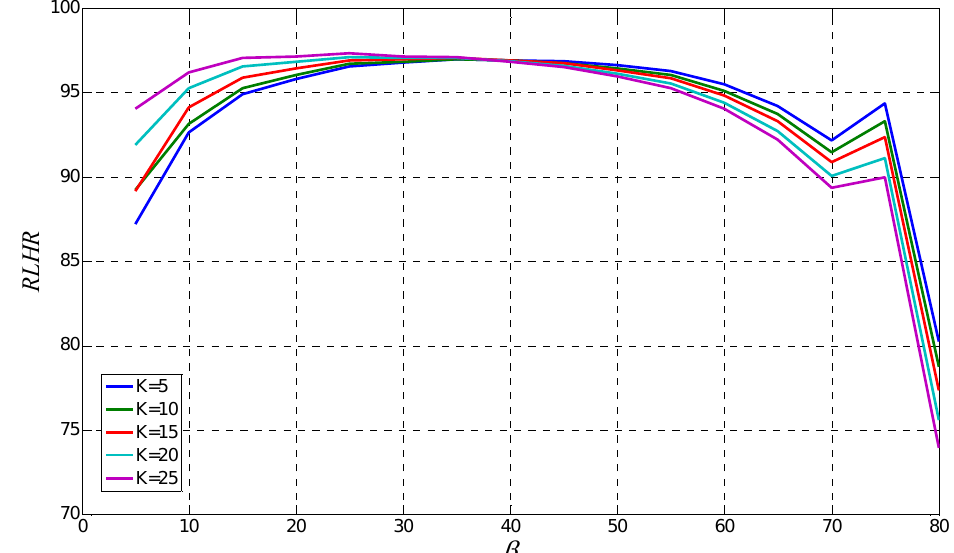
Figure 11. RLHR for text rotated by angle  from 0º up to